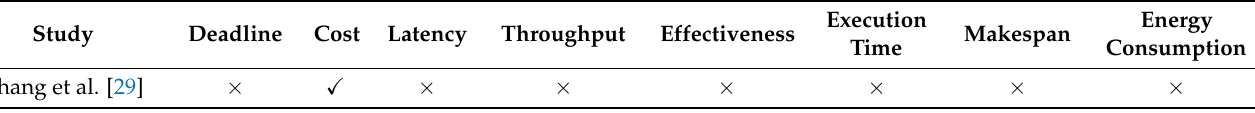
Table 5. Analysis of articles in terms of evaluation parameters in traffic monitoring